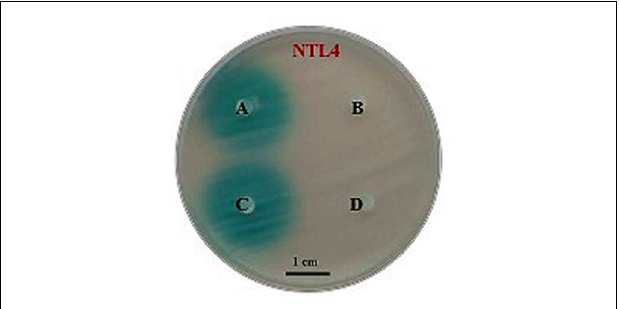
FIGURE 2 | Degrading activity by strain PQQ-42 of AHLs produced by pathogenic Vibrio spp. visualized on an agar plate assay by means of the biosensor strain Agrobacterium tumefaciens NTL4 (pZLR4). Cell-free MB medium added with Vibrio mediterranei VibC-Oc-097 AHL extracts (control; A) . Culture of strain PQQ-42 added with V. mediterranei VibC-Oc-097 AHL extracts (B) . Cell-free MB medium added with V. metschnikovii NCTC 8483 T AHL extracts (control; C) . Culture of strain PQQ-42 added with V. metschnikovii NCTC 8483 T AHL extracts (D) . Scale bar, 1